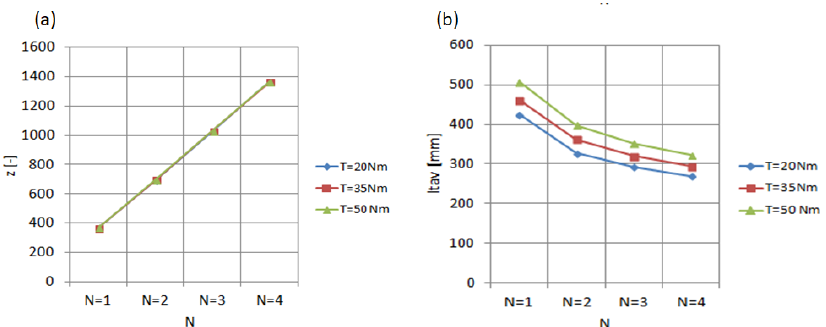
Figure 6. ( a ) Number of turns z and ( b ) average length of the turns l tav for individual excitation coils.